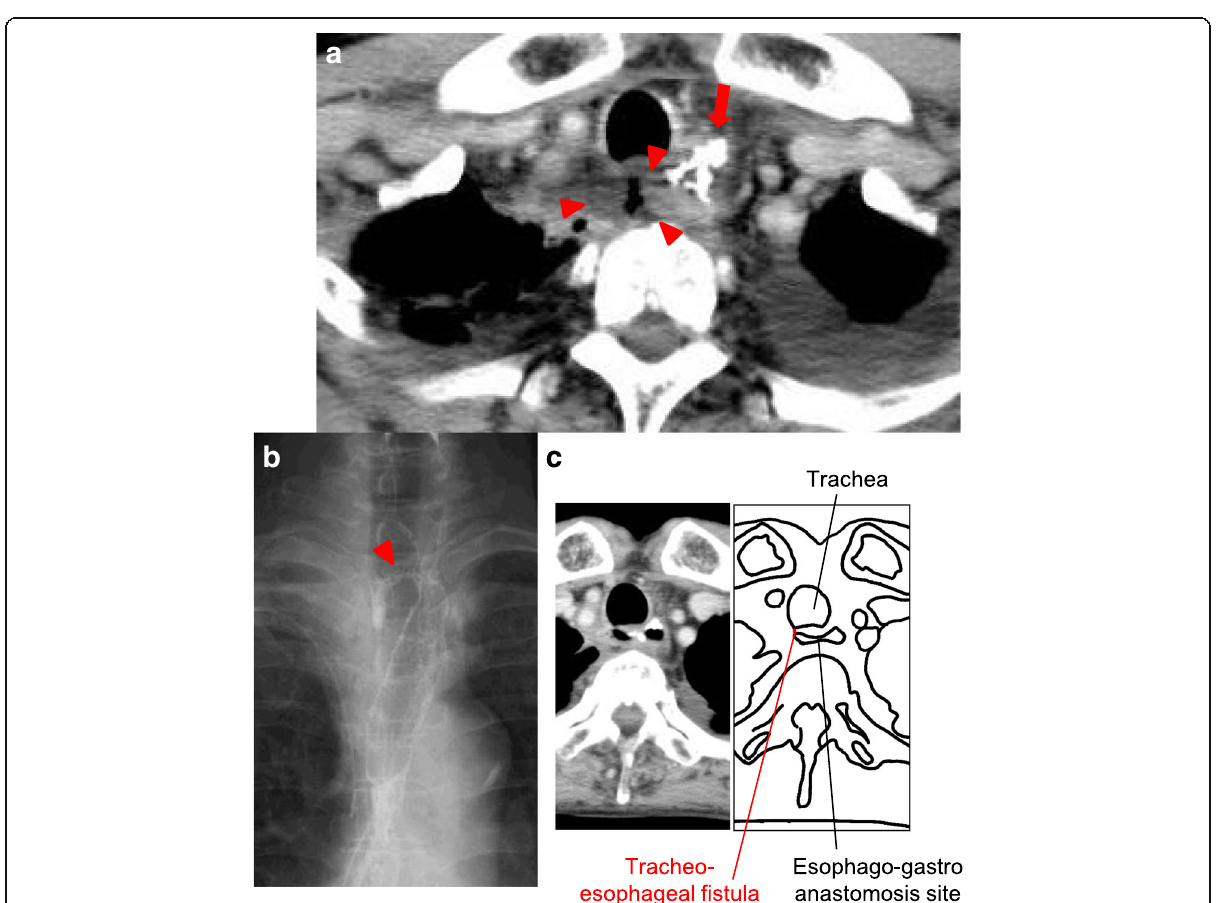
Fig. 2 Image findings of postoperative abscess and tracheoesophageal fistula (TEF). a The CT shows the leakage of esophagogastric anastomosis. The arrow indicates the hole of leakage and the arrowheads indicate the abscess. b , c The esophagography shows a TEF. The arrowheads indicate the